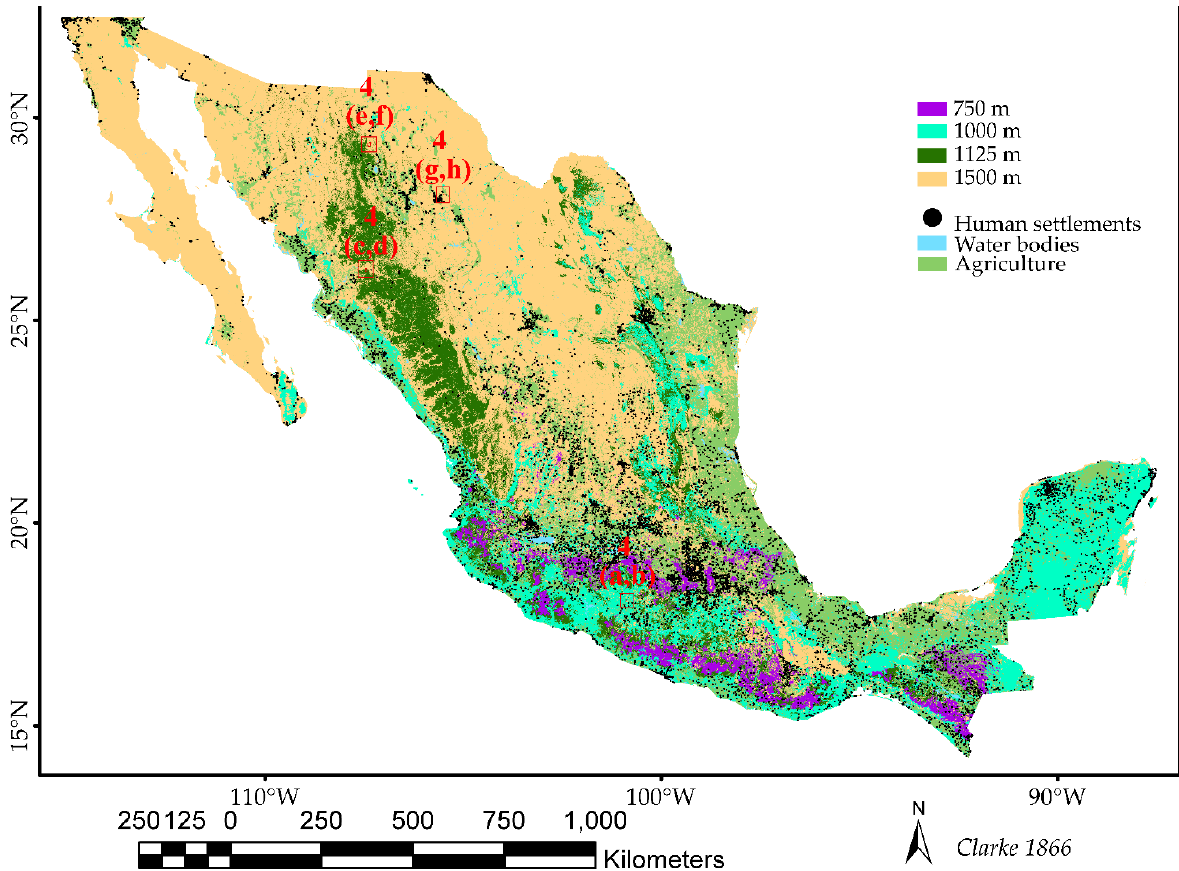
Figure 3. Map of best active fire aggregation distances for fire perimeter mapping by fuel types and regions. Human settlements are represented in black, water bodies in navy blue, and agriculture in green, based on the most recent land-use map (INEGI, 2014) [25]. The location of detailed windows (Figure 4) is shown in red.